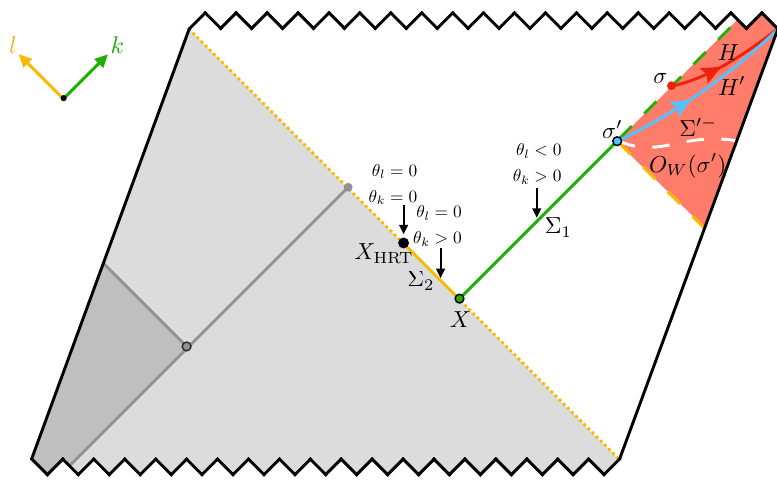
Figure 6 . Illustration of the construction of the HRT surface using the characteristic initial data formalism. The outer wedge O W ( (cid:27) 0 ) (red shading) of (cid:27) 0 (blue dot) is held (cid:12)xed. We (cid:13)ow along N k ( (cid:27) 0 ) until we reach a marginally antitrapped surface X . We then (cid:13)ow along N + l ( X ) while (cid:0) keeping cross sections of the light sheet stationary, until we reach a surface X HRT where (cid:18) k = (cid:18) l = 0 (black dot). The spacetime is completed (gray shading) by CPT re(cid:13)ection across N l ( X HRT ) (orange solid and dotted lines). The partial Cauchy surface (cid:6) 0(cid:0) (white dashed line) connecting (cid:27) 0 with the boundary by hypothesis satis(cid:12)es A [ (cid:26) ] > A [ (cid:27) 0 ] for all cross sections (cid:26) note that X HRT has minimal cross-sectional area on the Cauchy slice formed by the union of (cid:6) 0(cid:0) , (cid:6) 1 = N k ( (cid:27) 0 ) \ N + k ( X ) (green solid line), and (cid:6) 2 = N + l ( X ) \ N (cid:0) along with their CPT re(cid:13)ections, so X HRT is indeed an HRT surface.